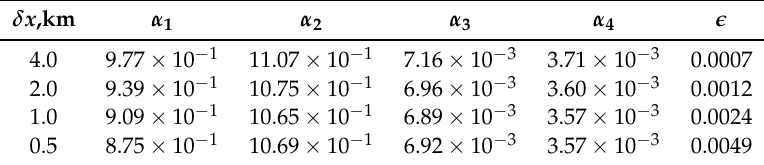
Table 1. Optimal rescaling coefficients and GOE approximation errors.